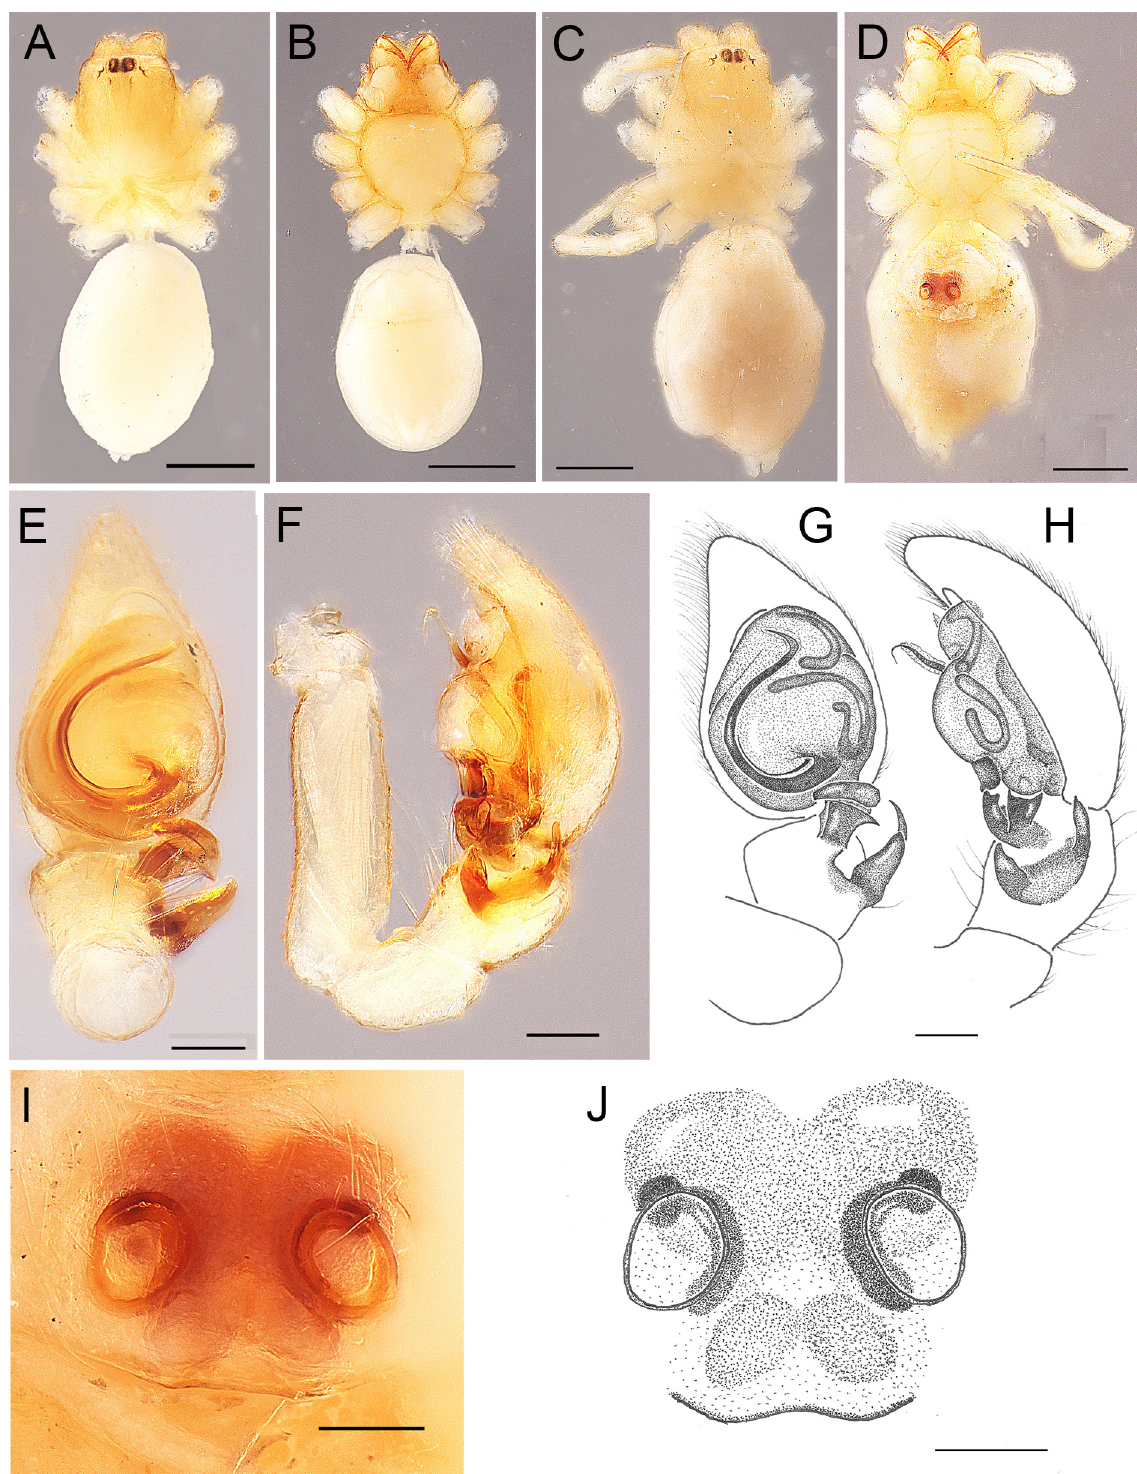
Fig. 33. Andromma raffrayi Simon, 1899. A–B, E–H . ♂, lectotype (MNHN AR1673). C–D, I–J . ♀, paralectotype (MNHN AR1673 ). A, C . Habitus, dorsal view. B, D . Same, ventral view. E, G . ♂, left palp, ventral view. F, H . Same, retrolateral view. I–J . Epigyne, ventral view. Scale bars: A–D = 1 mm; E–J = 0.1